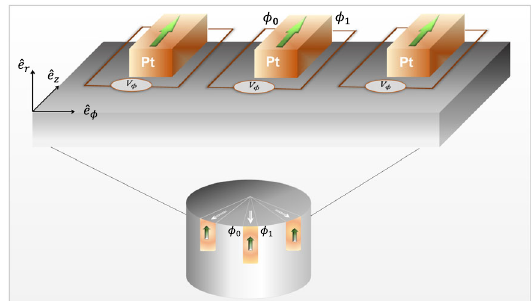
Fig. 3 Angular resolved ISHE measurement. Detections of the of the state cos ϑ ‘ R j i by the ϕ -resolved pumped spin density I z s ISHE. At the waveguide end, the z -polarized spins (green arrows) radially pumped into a narrow Pt layers result in an inverse spin Hall voltage V ϕ (cid:5) cos 2 ϑ ‘ with ϑ ℓ ≈ ℓ ( ϕ 0 + ϕ 1